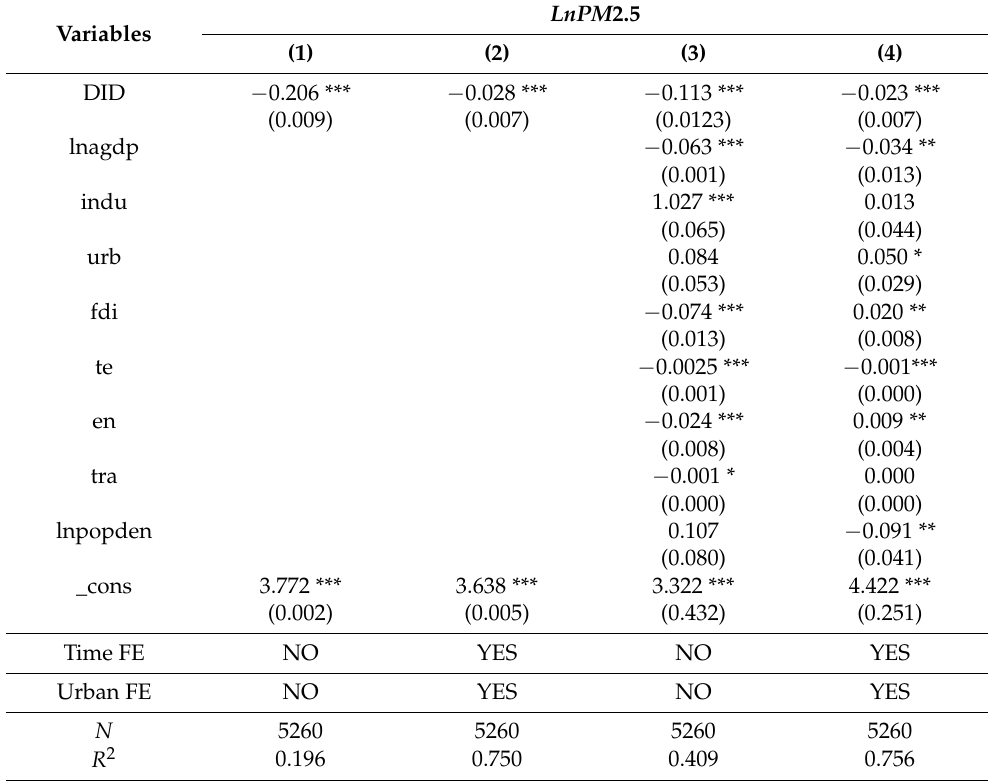
Table 2. Benchmark regression